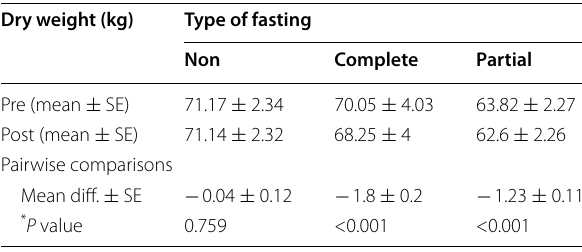
Table 3 Pre and post-fasting weight changes reported in the study